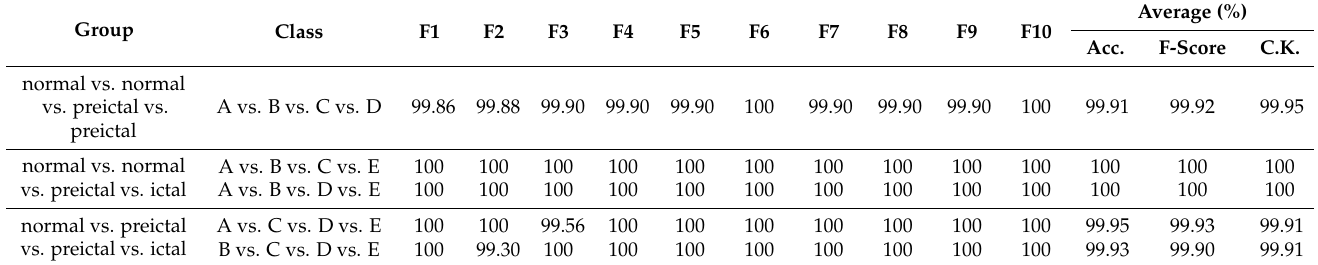
Table 4. Performance result of four-class with 10-fold CV, here Fi means ith fold and all results are in (%).